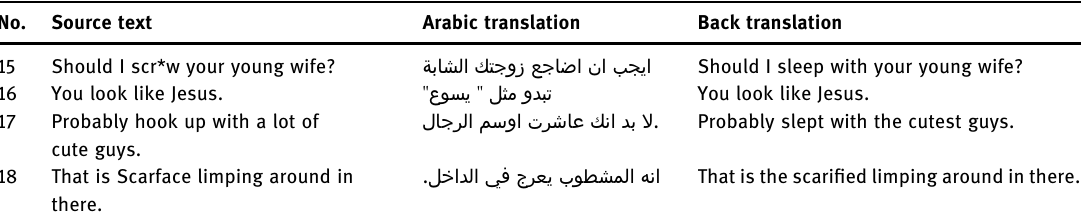
Table 11: Calque strategy examples No. Source text